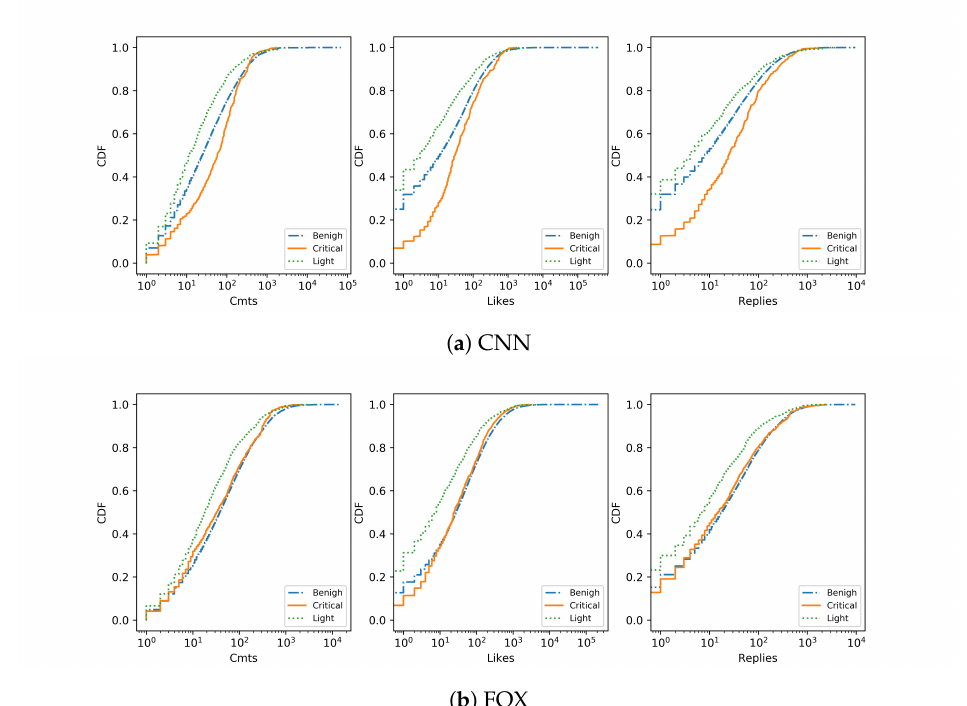
Figure 6. Users general activities on facebook discussion